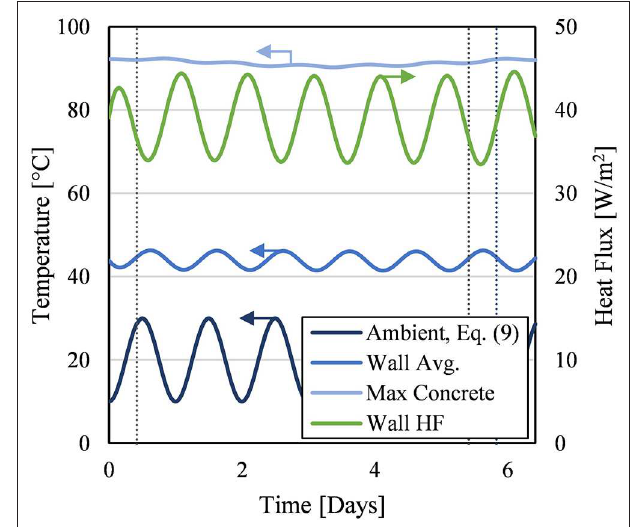
FIGURE 13 | Key results of temporally varying ambient conditions. Blue curves represent temperatures (left axis). Green curve represents heat flux (right axis). The “Wall Avg.” and “Wall HF” are area-weighted averages of temperature and heat flux, respectively, over the entire exterior surface of the silo. Positive heat flux means heat leaving the exterior wall to the ambient. Gray vertical lines mark changes in operating step.